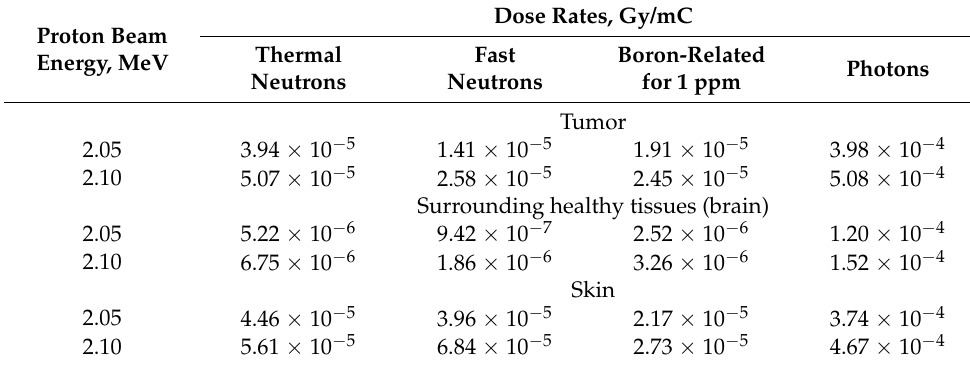
Table 2. Parameters used for irradiation dose